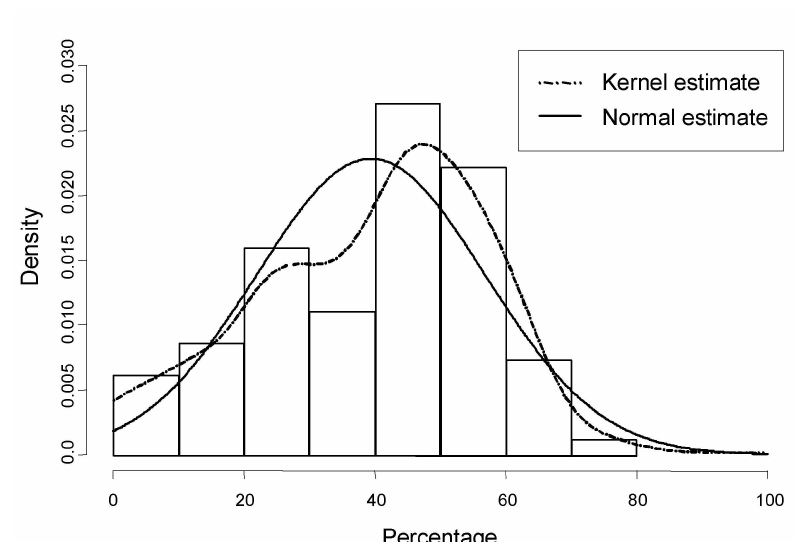
Figure 1: Histogram with density estimates of the Test Battery 1 variable FYWUM for the 1999 intake